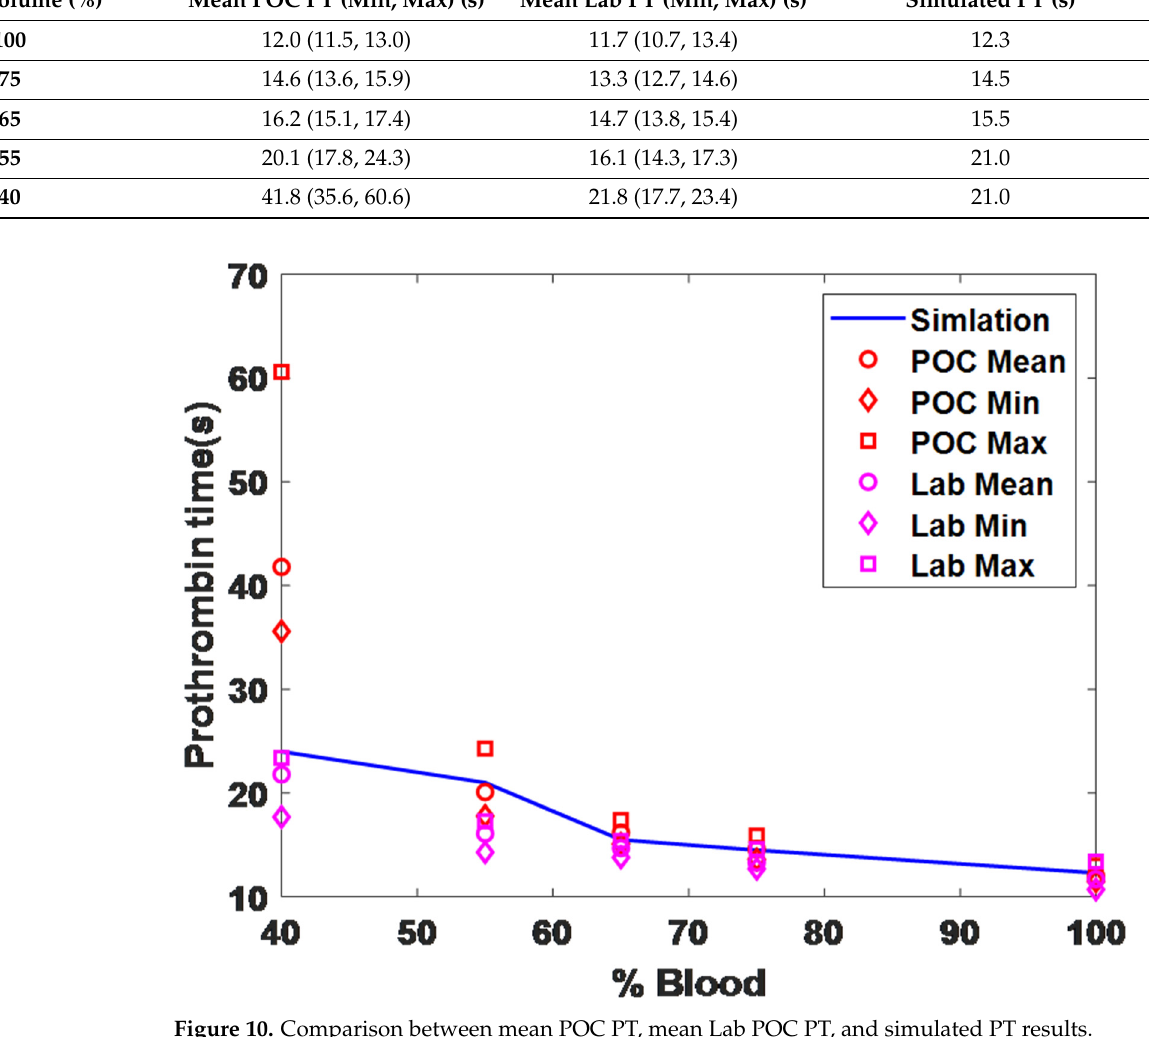
Figure 10. Comparison between mean POC PT, mean Lab POC PT, and simulated PT